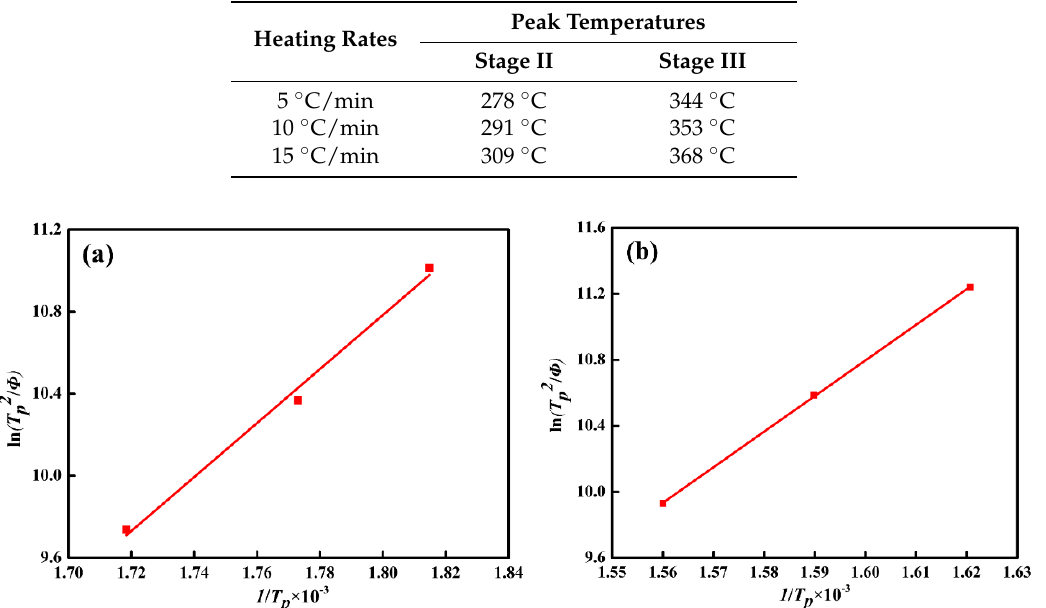
Table 3. The peak temperatures of Stage II and Stage III without applied stress at different heating rates.